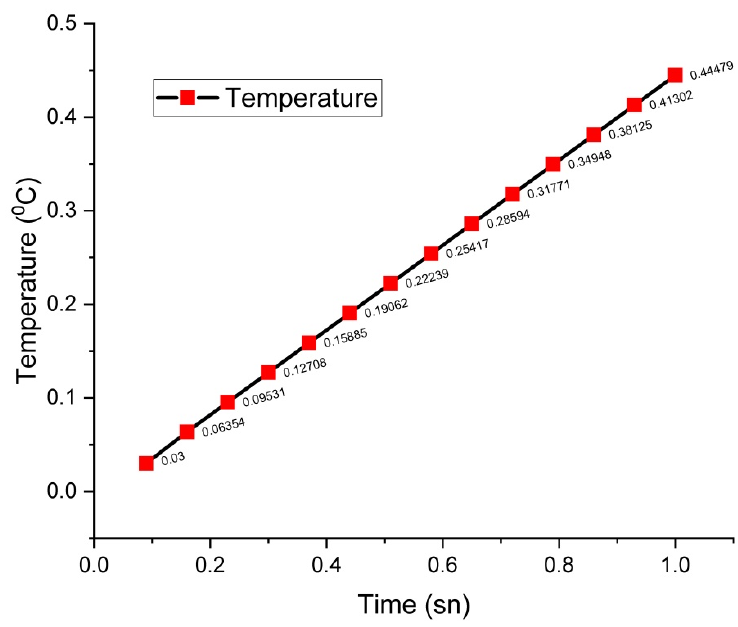
Figure 4. Heat transitions of the model at ( a ) 1 s, ( b ) 2 s, ( c ) 3 s and ( d ) 4 s.